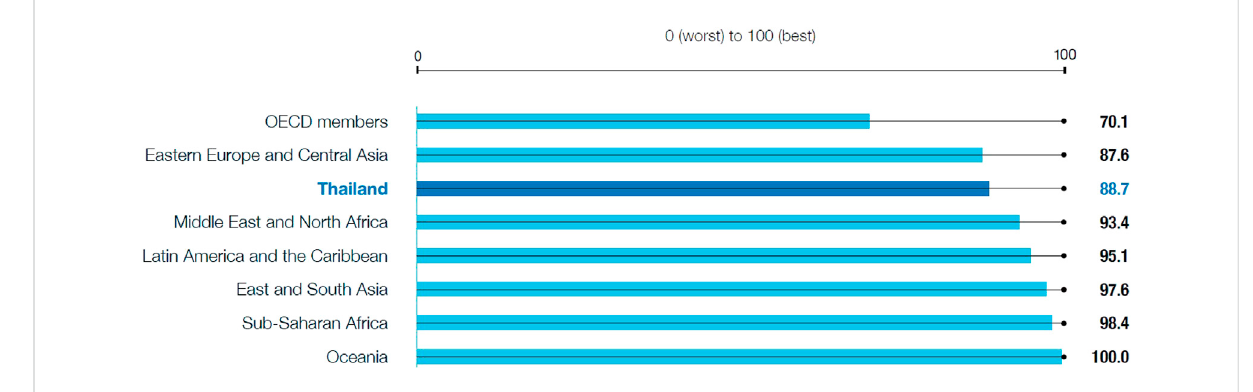
FIGURE 2 International spillover index; Thailand, sourced (Kroll et al., 2021).